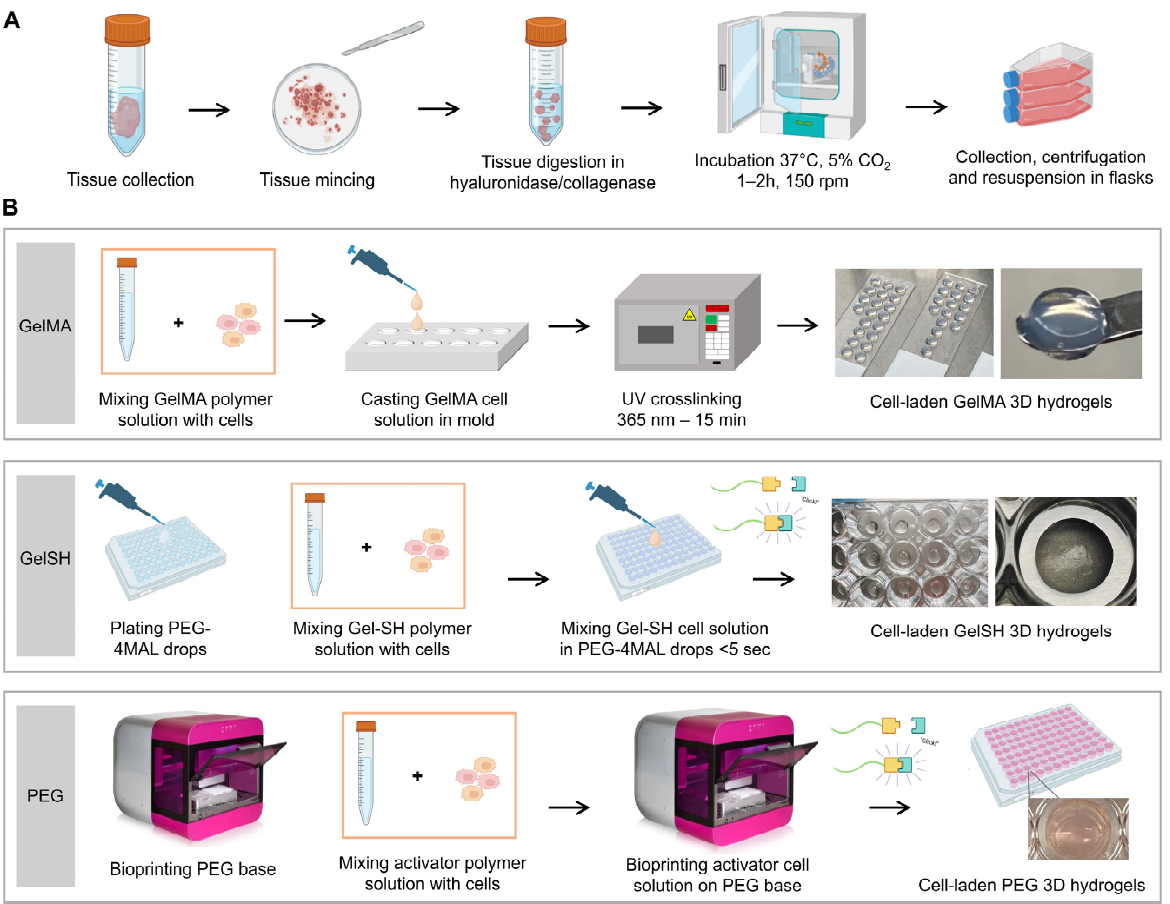
Figure 1. Schematic representation of tissue processing from tumor collection and preparation ( A ) to encapsulation into 3D hydrogels ( B ). GelMA = gelatin methacryloyl. GelSH = Gel-SH/PEG-4MAL, PEG = polyethylene glycol. Figure partly created with BioRender.com.